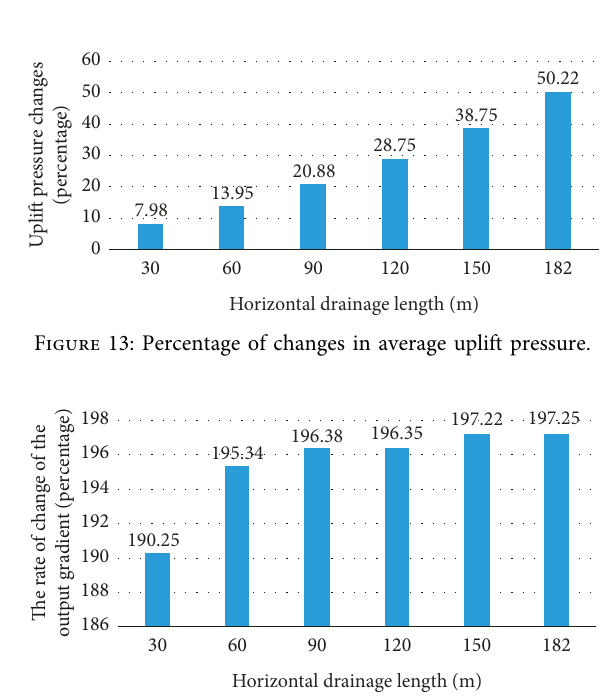
Figure 17: Percentage reduction of exit gradient in different po- sitions of horizontal drainage.